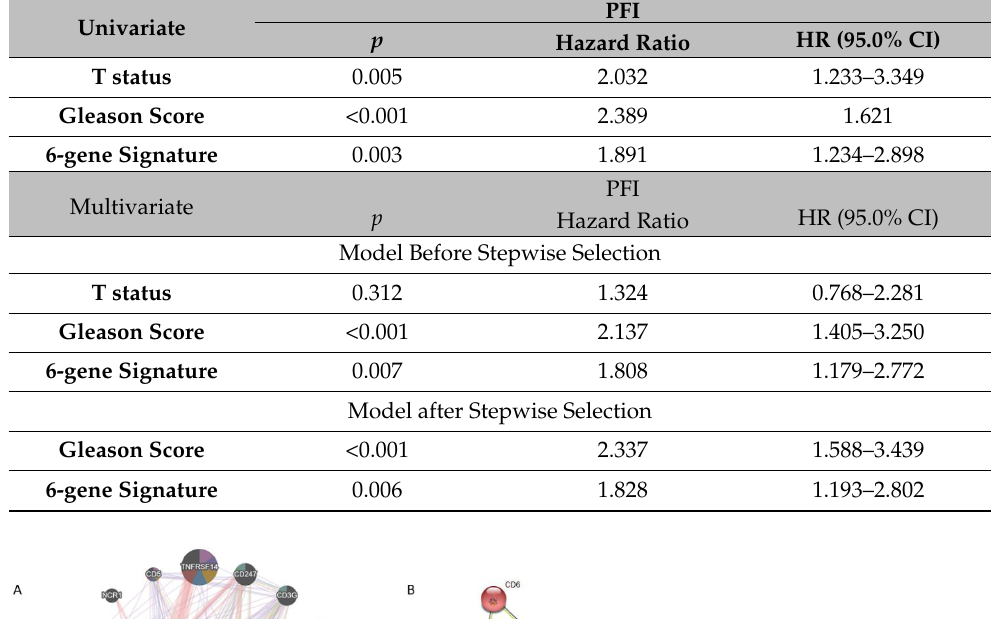
Table 2. Univariate and multivariate survival analyses (Cox regression) were conducted by IBM SPSS 24. For the multivariate analysis, the forward stepwise method with a threshold of 0.05 as an entry point was used.